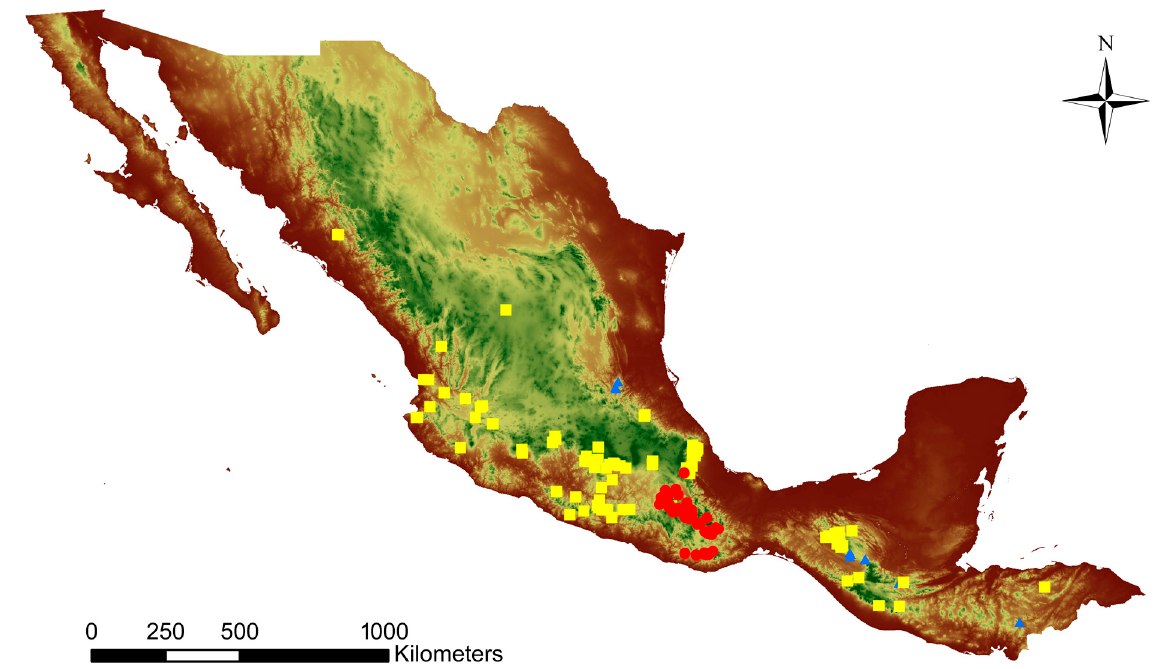
Figure 2. Actual distribution of Mesoamerican Cypripediums from herbarium data. Cypripedium irapeanum = yellow points, C. molle = red points, and C. dickinsonianum = blue points.